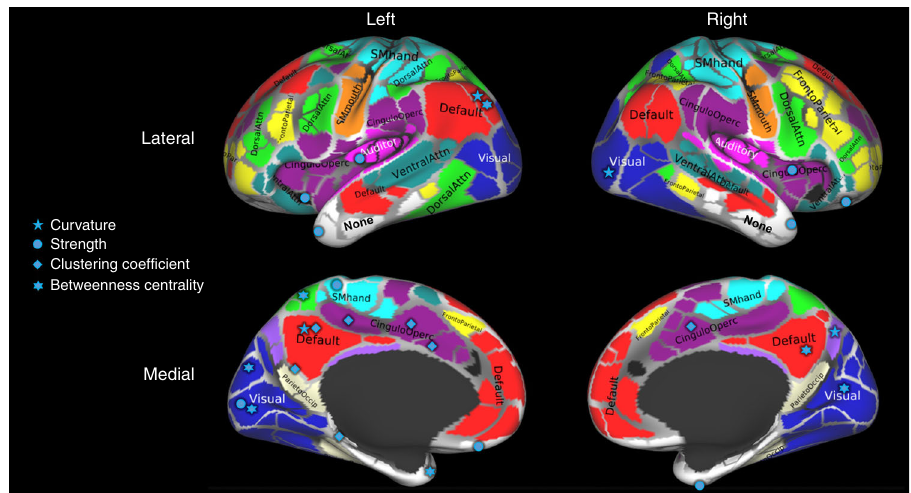
Fig. 3 Nodes with statistically signi fi cant changes (corrected for multiple comparisons using the Holm – Sidak method) in structural connectivity due to age. Brain parcellation with 333 cortical areas was done using the Gordon atlas 25 and labeled using the Brain Analysis Library of Spatial maps and Atlases database https://balsa.wustl.edu/WK71. Adapted from Fig. 10 of Supplementary data from Gordon et al. 25